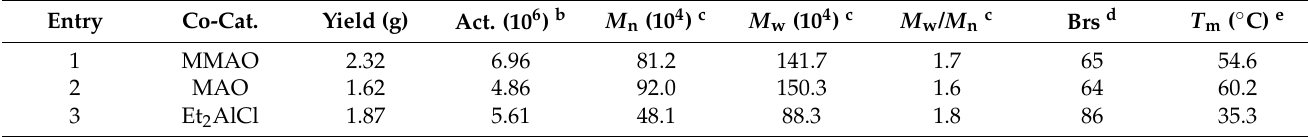
Table 1. Effect of cocatalysts on ethylene polymerization catalysed by Ipty/ i Pr-Ni a